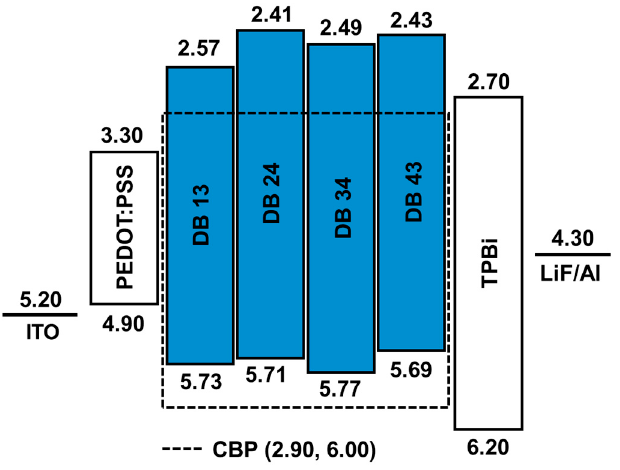
Figure 11. Energy-level diagram in eV of the solution-processed blue OLED devices containing emitters DB 13, DB 24, DB 34, and DB 43 doped in CBP host material. Table 2. Electroluminescent (EL) characteristics of the devices with emitters DB34, DB24, DB43 and DB13 doped in CBP host matrix at varying concentrations, displaying turn-on voltage at luminance >1 cd m − 2 , power efficacy, current efficacy, external quantum efficiency, CIE, and maximal